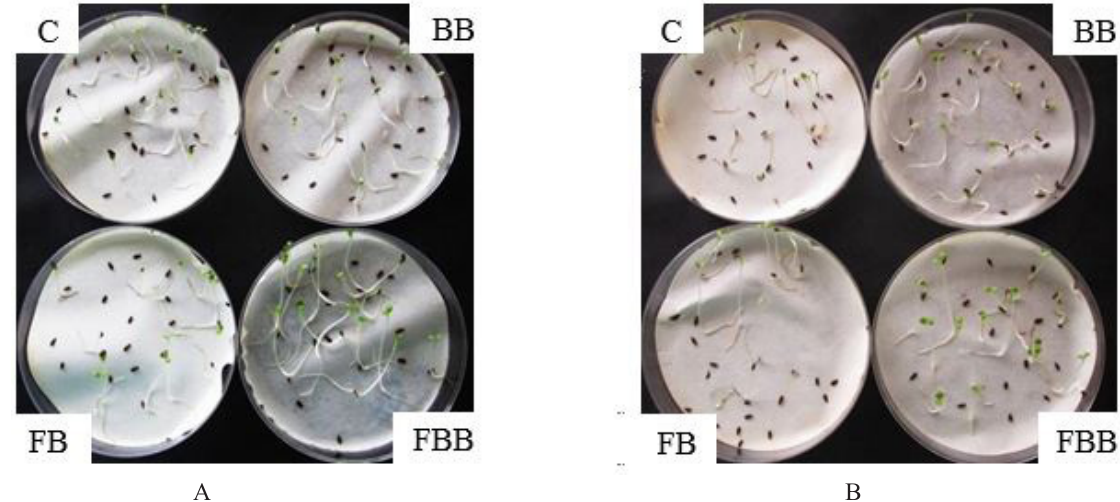
A B Figure 5: The lettuce seedlings A. treated with biofilm exudates collected at 0.5 day; B. treated with biofilm exudates collected at day 6 (C - Control, BB - Bacterial biofilm, FB - Fungal biofilm, FBB- Fungal-bacterial biofilm). Table 1: Pearson correlation coefficient (r) showing relationships of the seedling vigor and germination percentage of lettuce with functional polysaccharides, fatty acids and amides of the